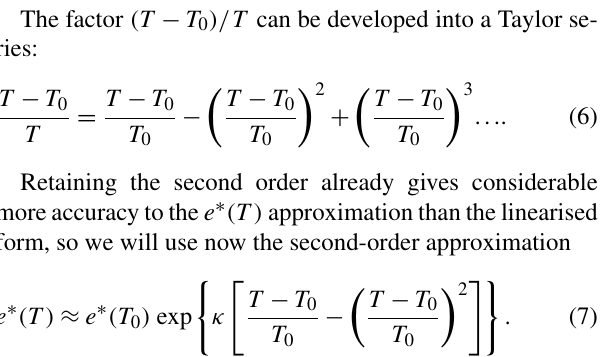
Figure 2. Ratio of first- (black) and second-order (red) approxima- tions of the Planck function to the true Planck function vs. tempera- ture, T . The wavelength for the calculation of the Planck functions was 6 .